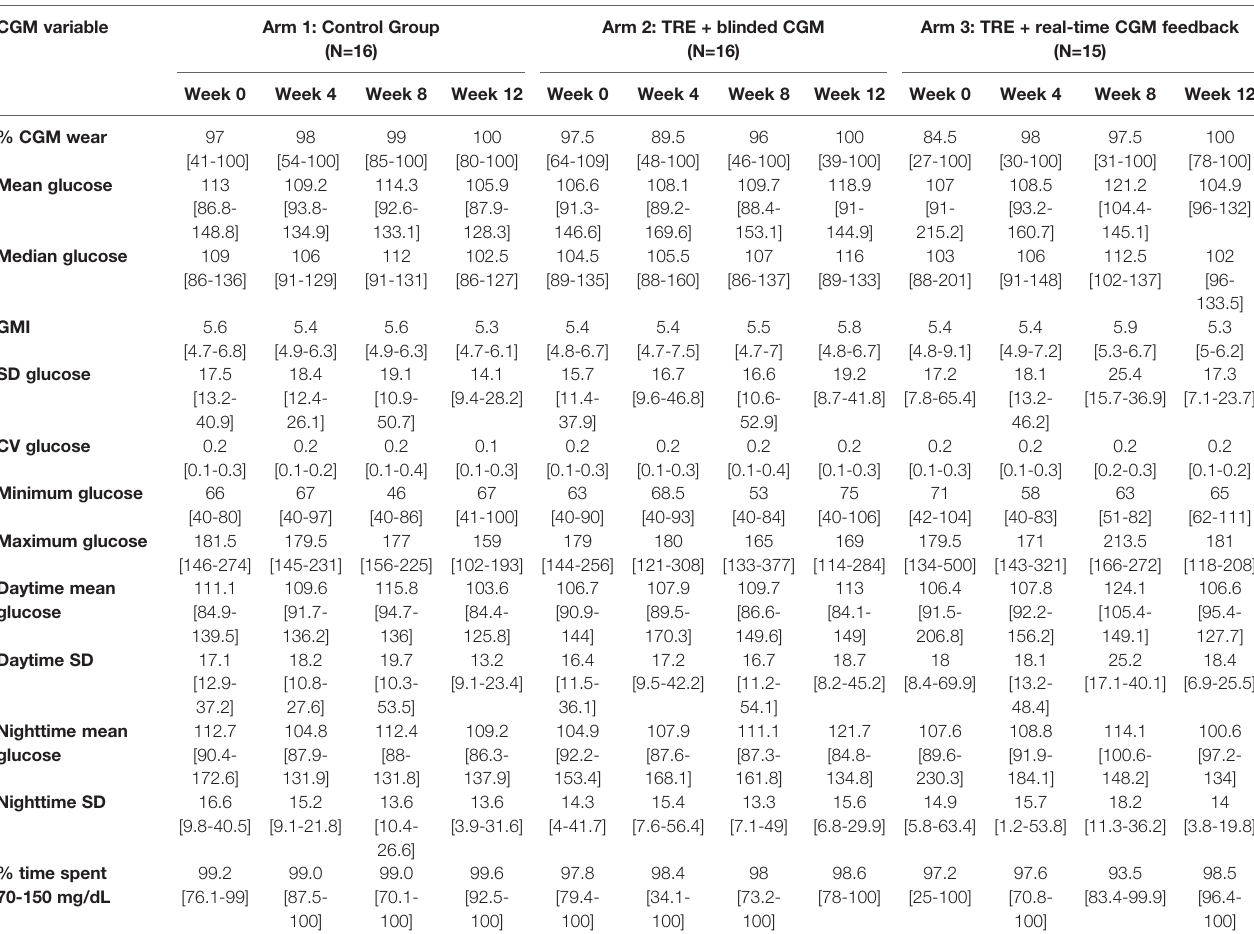
TABLE 2A | Continuous glucose monitor